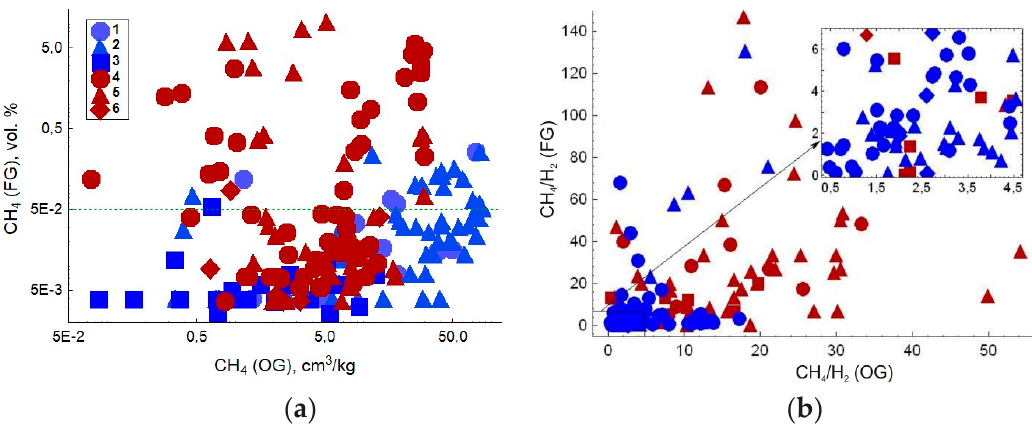
Figure 12. Relationships between the occluded and free gas СН 4 concentration ( a ) and СН 4 / Н 2 ratio ( b ) (modified from [18]). The FG samples were taken from shot-holes 10 min after the drilling and sealing. The OGs were extracted from the rock samples taken near the shot-hole mouths. Symbols: 1 - nepheline syenites; 2 - foidolites; 3 - apatite-nepheline ore of the Khibiny deposits; 4 - foyaite; 5 - lujavrite; 6 - urtite of the Lovozero loparite deposit. The dashed line in Figure 12a designates a conditional border below which the predominantly diffusive release of free gases is assumed.